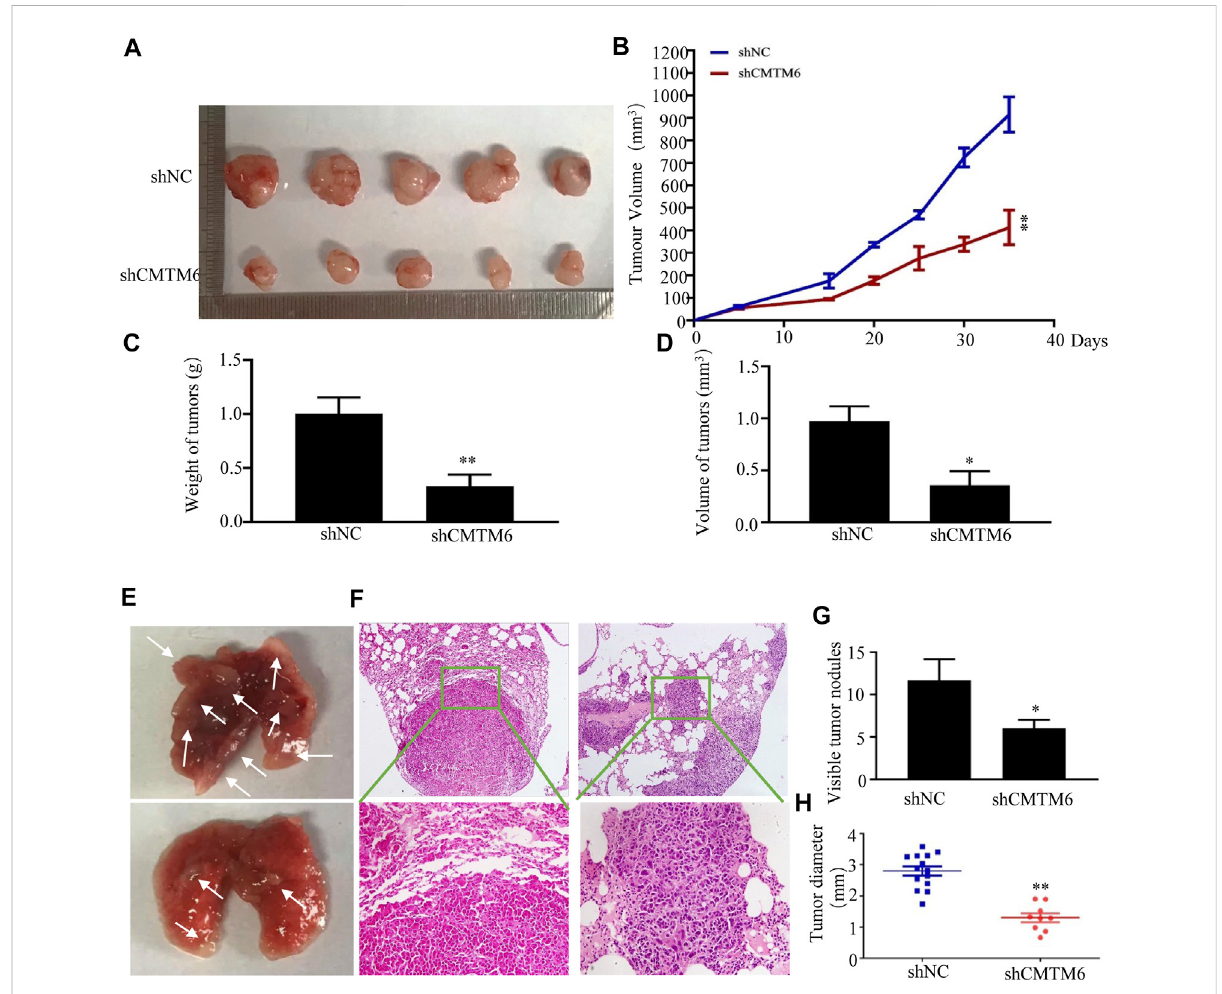
FIGURE 4 CMTM6 promotes CCcell growth and metastasis in vivo . (A) Representative images of tumor formedin each group. (B – D) Quantitative growth curvesforthetumorvolumeandweightineachgroup,expressedasmean±SEM.* p < 0.05;** p < 0.01; (E) Imageofmetastaticlungnodulesinmice injectedwithHCCcells via tailvein.Thearrowindicatesametastatictumoronthesurfaceofthelung. (F) RepresentativeH&Estainedsectionsoflung metastasis nodules. (G – H) At 3 weeks following CC cell tail vein injection, the number and diameter of lung nodules were determined in nude mice ( n = 6 per group). SPSS and GraphPad software were used for statistical